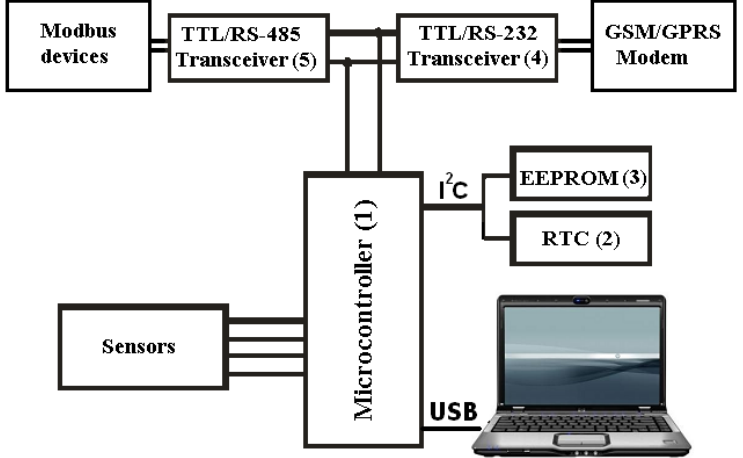
Figure 2. Simplified diagram of the proposed